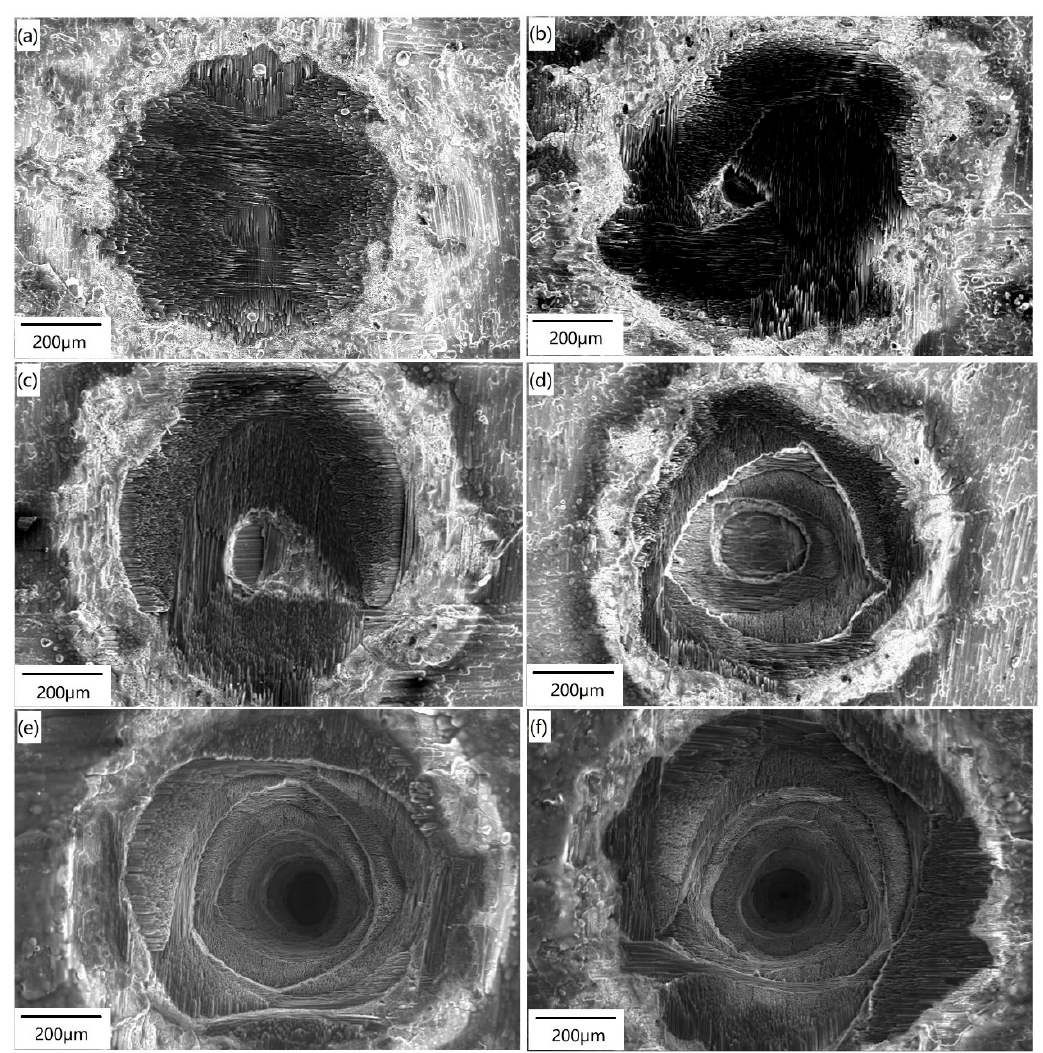
Figure 6. Surface morphology of the C/SiC composite irradiated under Condition D with different pulse numbers: ( a ) 1 pulse; ( b ) 2 pulses; ( c ) 5 pulses; ( d ) 10 pulses; ( e ) 50 pulses; ( f ) 100 pulses.